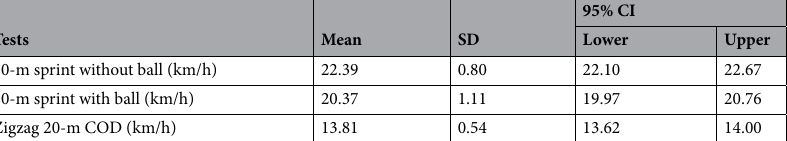
Table 1. Description of the performance obtained in the 20-m sprint tests without the ball, 20-m sprint tests with the ball, and Zigzag 20-m COD test. SD standard deviation, CI confidence interval, COD change-of- direction.